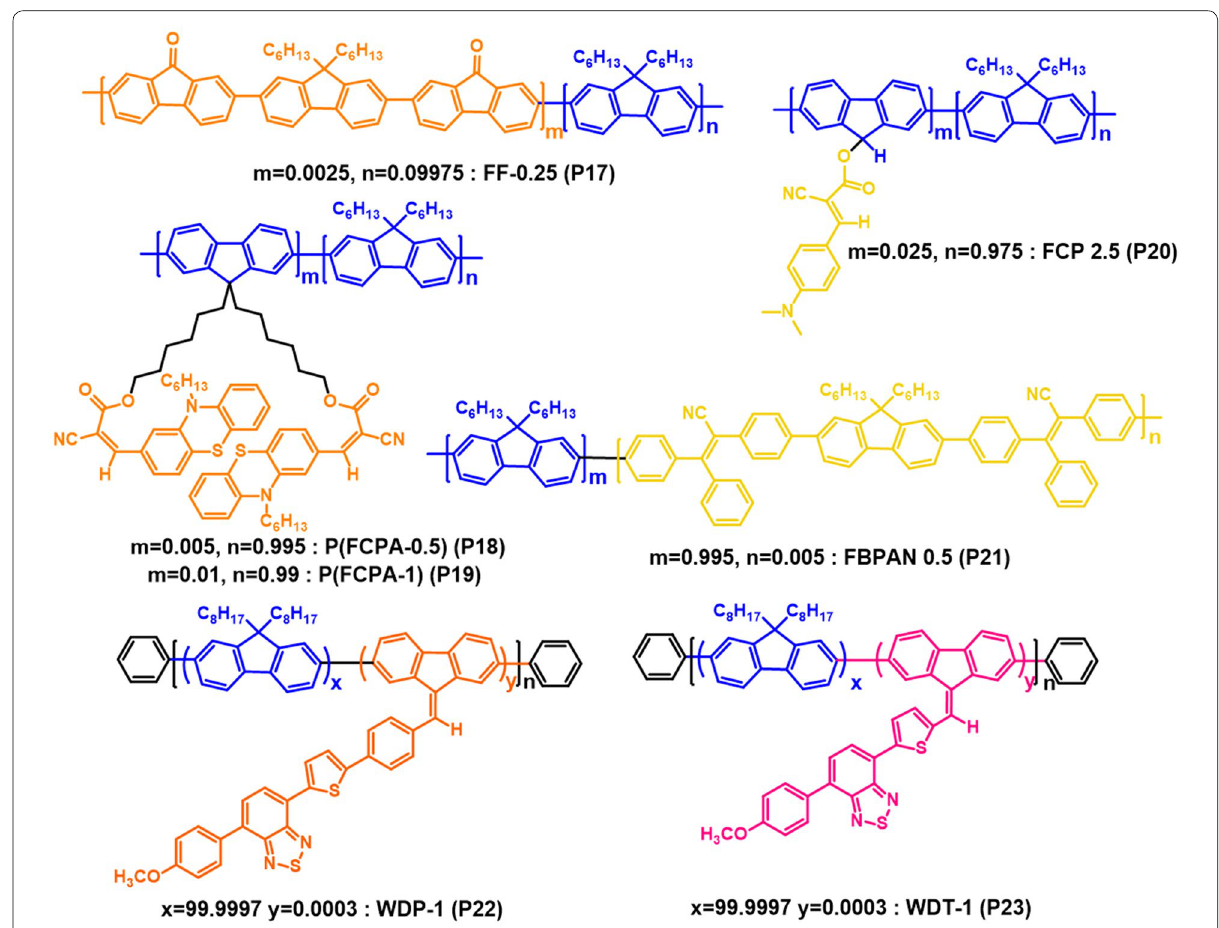
Fig. 13 Chemical structures of AIEE active